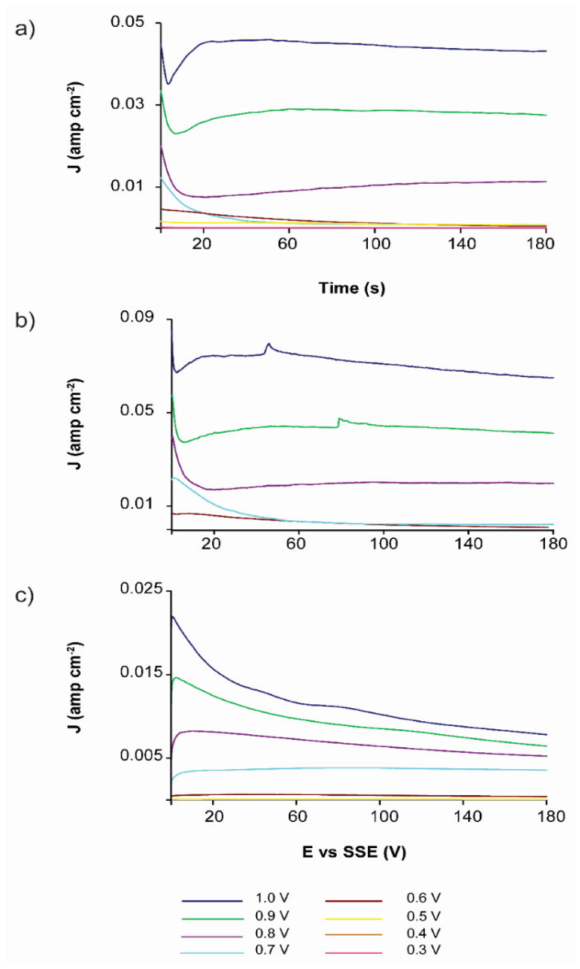
Figure 6. Typical current transient of CPE-ZnS voltamperograms (70:30 wt.%) obtained without electrolyte agitation. ( a ) 0.1 M Na 2 SO 4 , pH = 7; ( b ) 0.1 M H 2 SO 4 , pH = 2; ( c ) 1.7 M H 2 SO 4 . The colors indicate different potentials